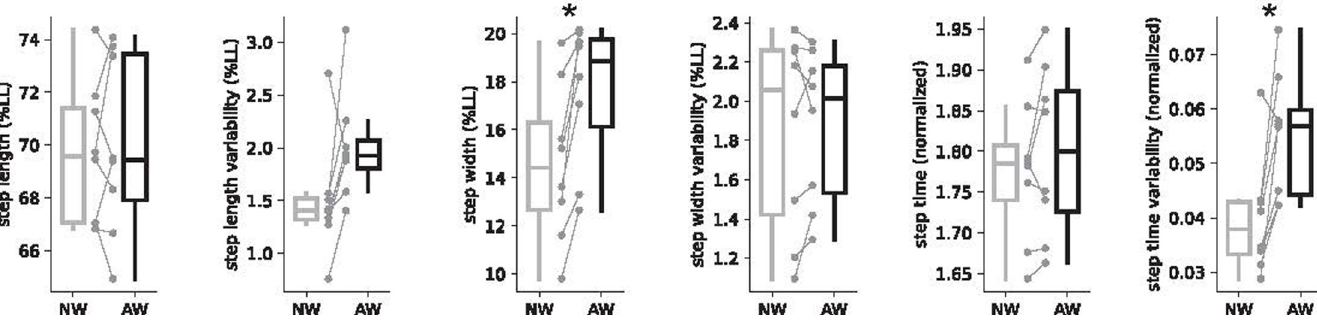
Fig 3. Box and whisker plots for all stepping parameters during normal (NW) and assisted (AW) walking conditions. Individual data points are superimposed and connected to show paired data ( n = 8). Most notably, all subjects increased their average step width. Additionally, seven out of eight subjects exhibited an increase in step time variability. Asterisks indicate p <